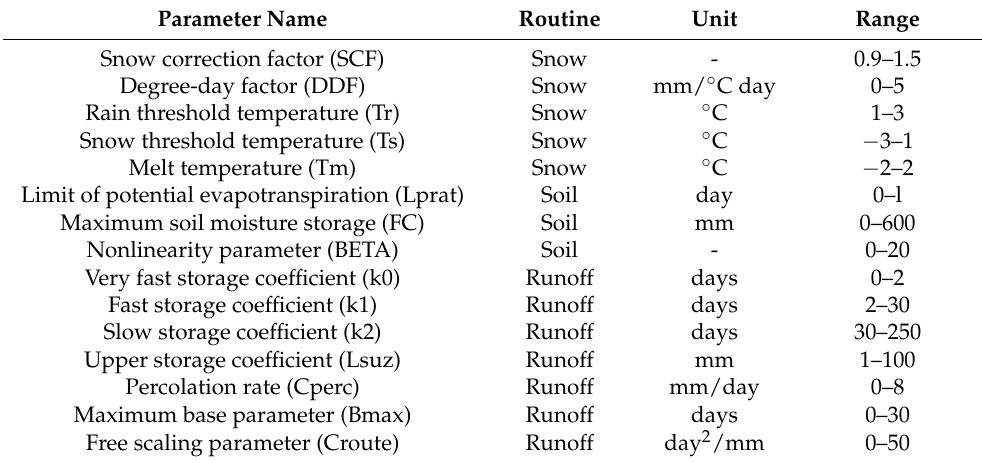
Table 4. 15 TUW model parameters sorted due to the routines and their calibration